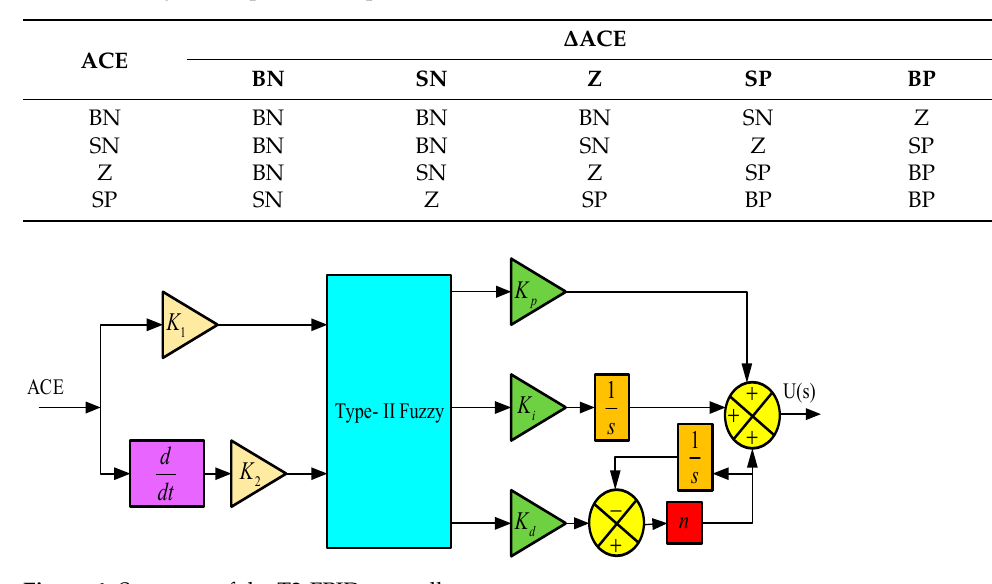
Table 1. FLC system input and output rules.